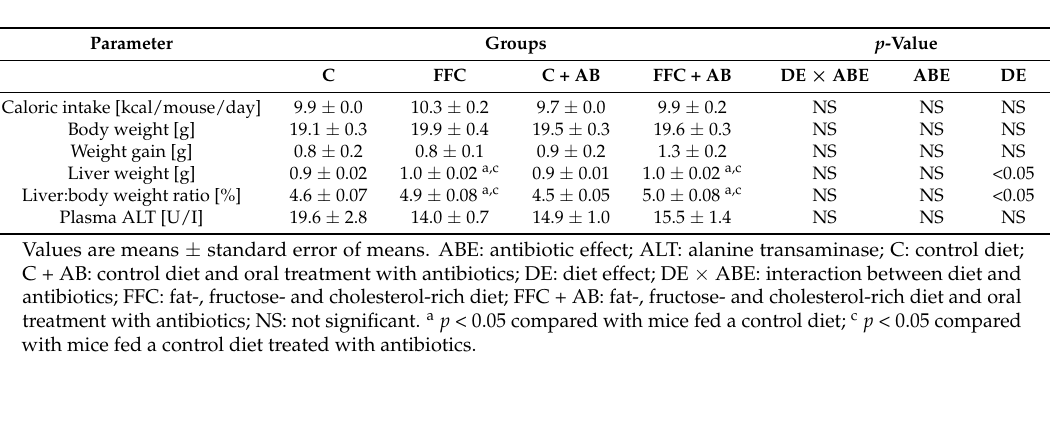
Table 2. Caloric intake, body weight gain and markers of liver health of mice fed short-term a FFC or control diet ± antibiotic